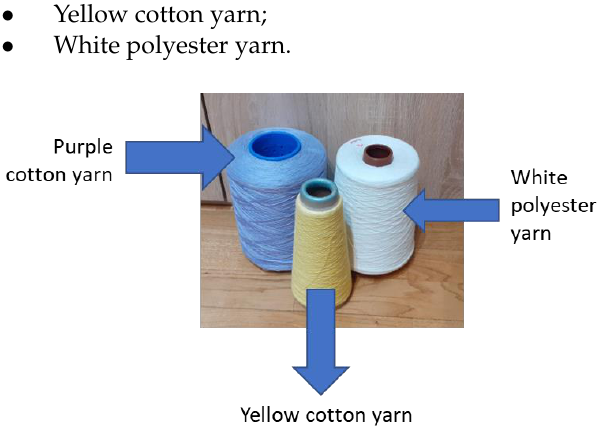
Figure 35. Three types of textile yarn tested.